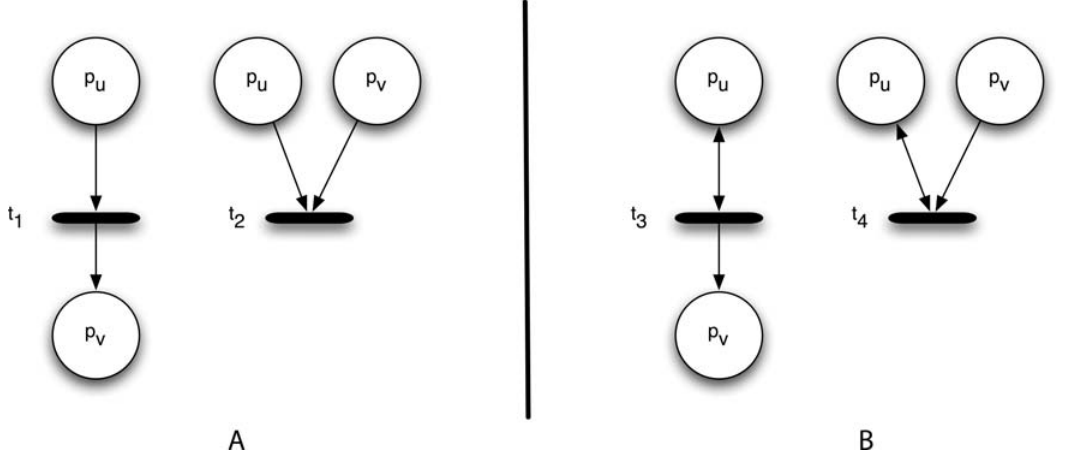
Figure 5. The Topological Motifs for Differing Signaling Processes. (A) The token consumption motifs for complexing and recruitment. Transition t 1 encodes activation of v by the binding or consumption of u. Transition t 2 encodes deactivation of v by the binding or consumption of u. In both cases, the number of tokens of p u decreases immediately after transitions t 1 and t 2 fire. (B) The token conserving motifs for PTM and GTP/ATP binding. Transition t 3 encodes enzymatic activation of v by u. Transition t 4 encodes enzymatic inhibition of v by u. In both cases, the number of tokens of p u remains unchanged immediately after transitions t 3 and t 4 fire.